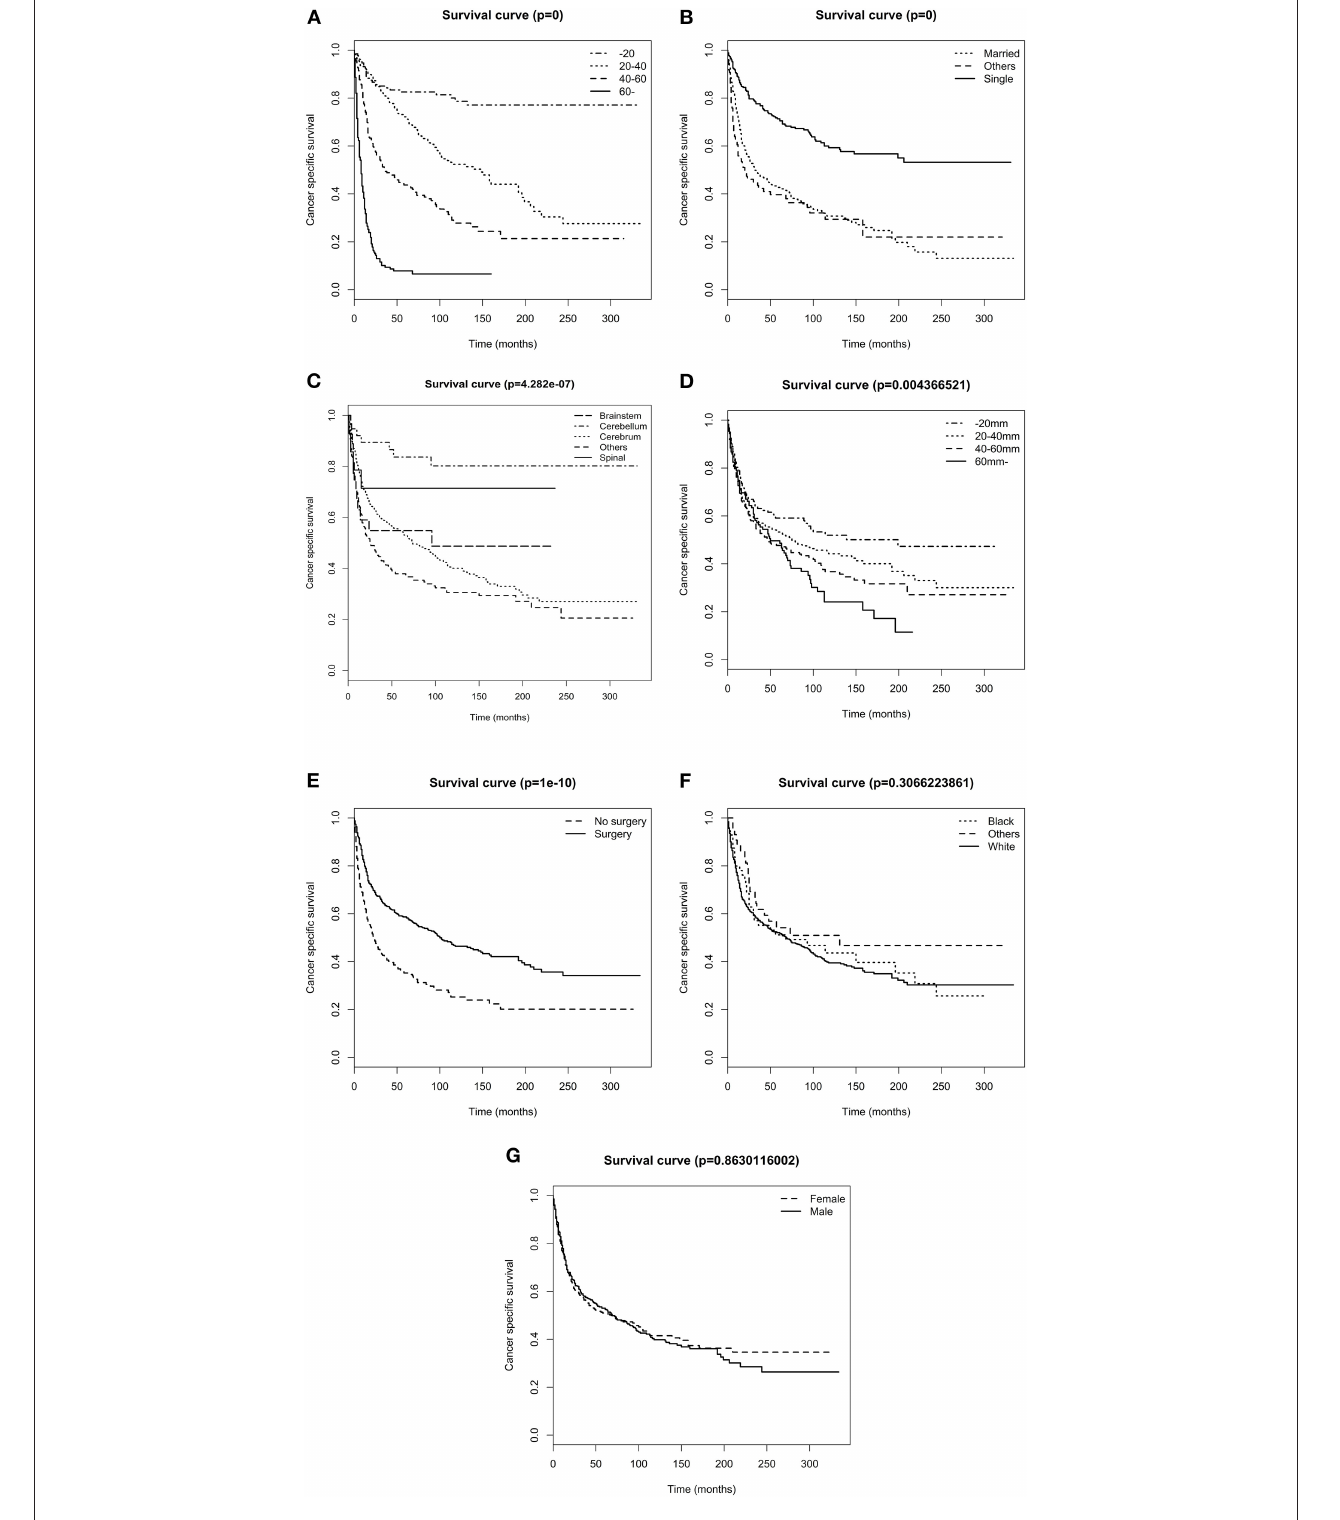
FIGURE 1 | Survival analysis of patients stratified by risk factors. (A) age (B) marital status, (C) primary tumor site, (D) tumor size, (E) surgery, (F) race, and (G) sex.